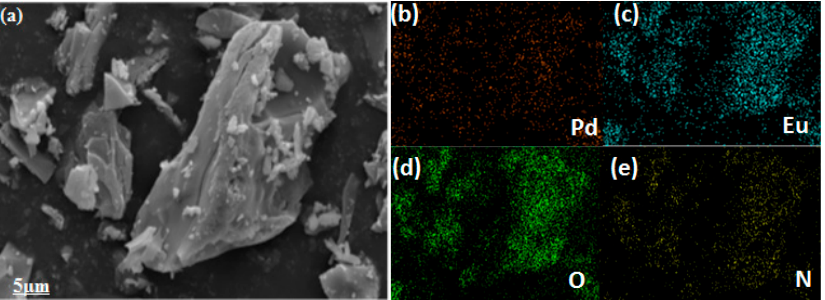
Figure 3. SEM (a) and the corresponding elemental mapping images of Pd-NHC@Eu-BCI (b-e).